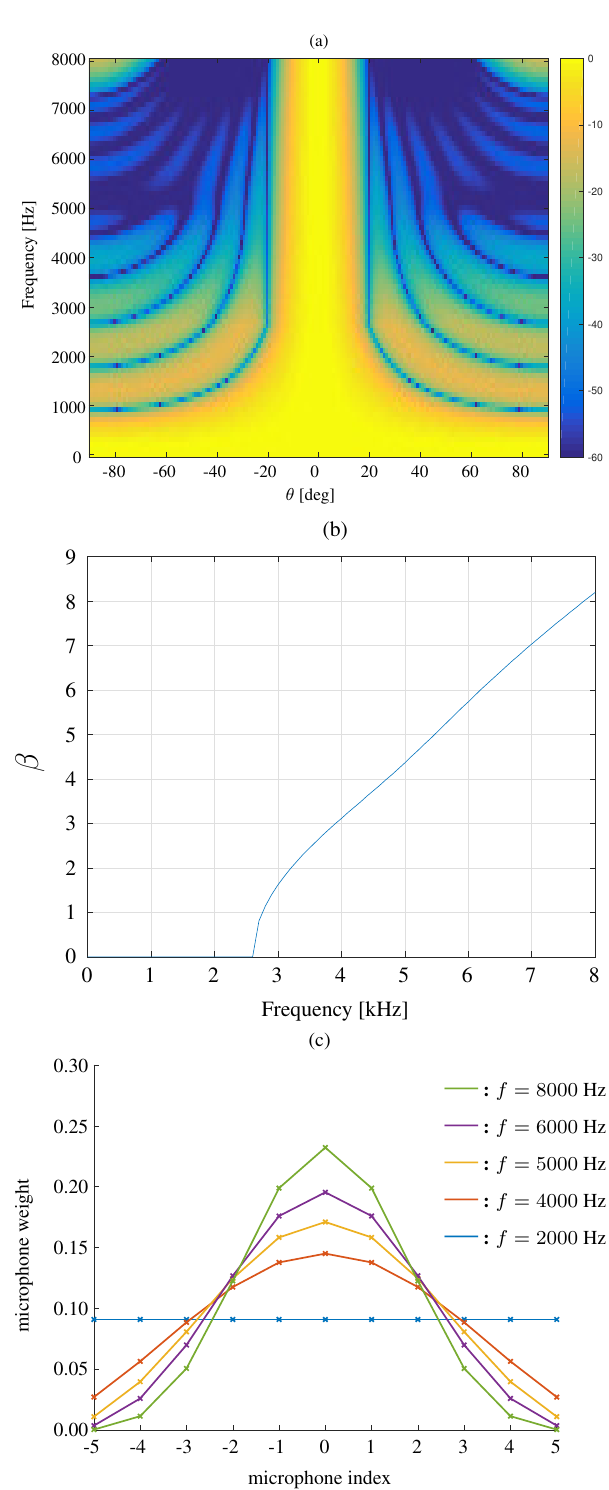
Figure 9. Constant beamwidth beamforming using the Kaiser window-based method: ( a ) constant beamwidth beampattern, ( b ) the parameter β , ( c ) the weights of microphones for different frequency bins. The beamwidth is fixed to 40 ◦ , M = 11, δ = 3.5